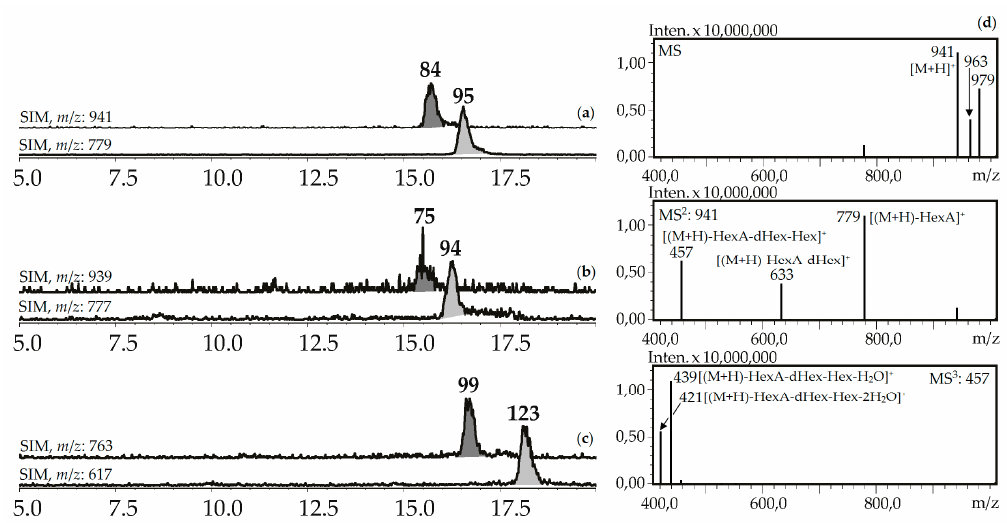
Figure 8. ( a,b,c ) HPLC-ESI-MS chromatograms of G. asclepiades herb extract in SIM-mode (positive ionization; m / z 941, 779 (oleanolic acid glycosides; a), 939, 777 (dehydrooleanolic acid glycosides; b), 763, 617 (desoxyoleanolic acid glycosides; c)). ( d ) MS n spectra (positive ionization) of compound 84 .